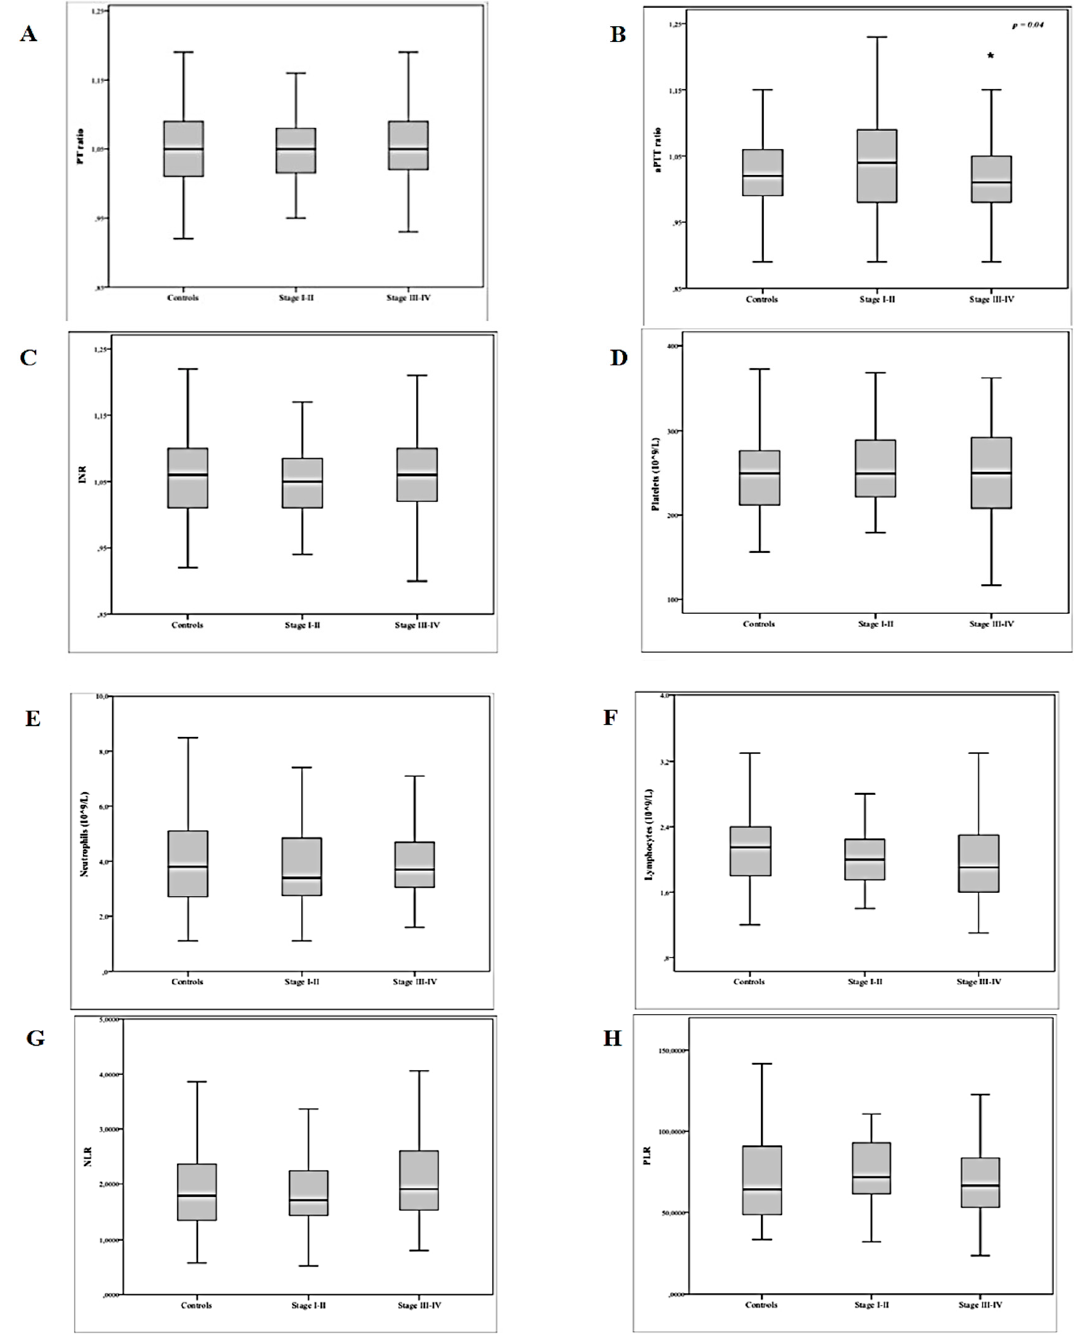
Figure 1. Boxplots of levels of coagulation parameters and systemic inflammatory response parameters according to di ff erent stages of endometriosis ( n = 259). ( A ) PT, prothrombin time; ( B ) aPTT, activated partial thromboplastin time; ( C ) INR, international normalized ratio; ( D ) PLC, platelet count; ( E ) N, neutrophil count; ( F ) L, lymphocyte count; ( G ) NLR, neutrophil-to-lymphocyte ratio; ( H ) PLR, platelet-to-lymphocyte ratio. * p =